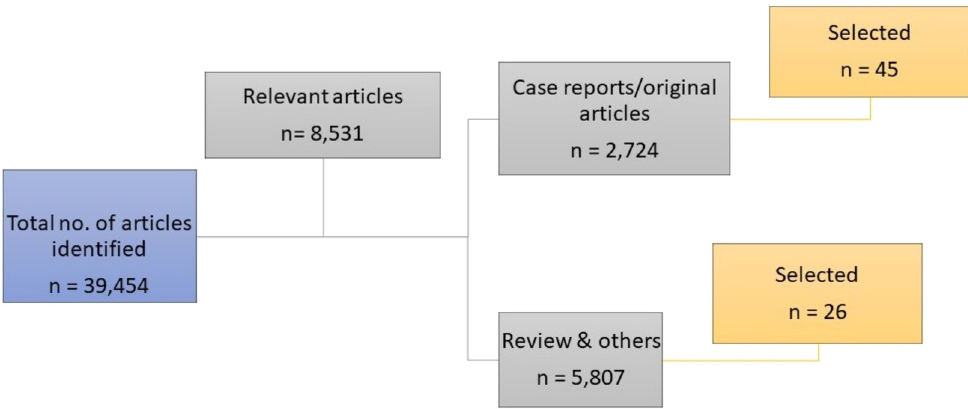
Figure 1: Filtering processes and article selections in the study.